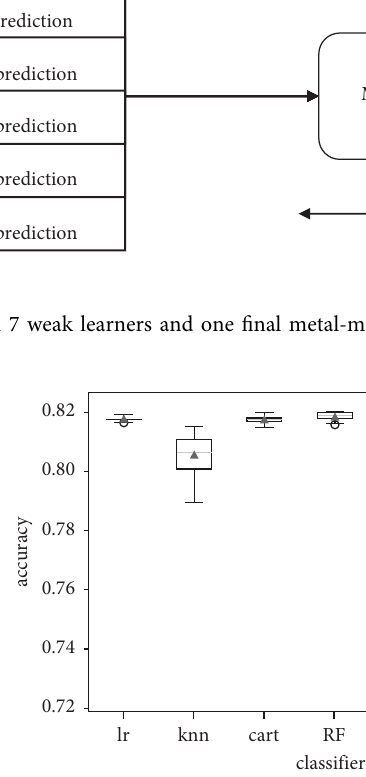
Figure 7: Box–Whisker plots comparing the performance of the classifers.